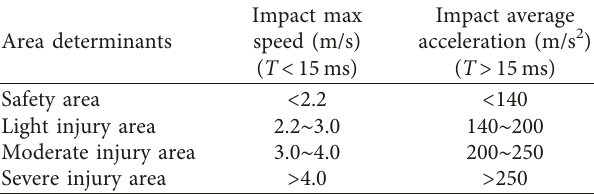
Table 3: Division of physical injury